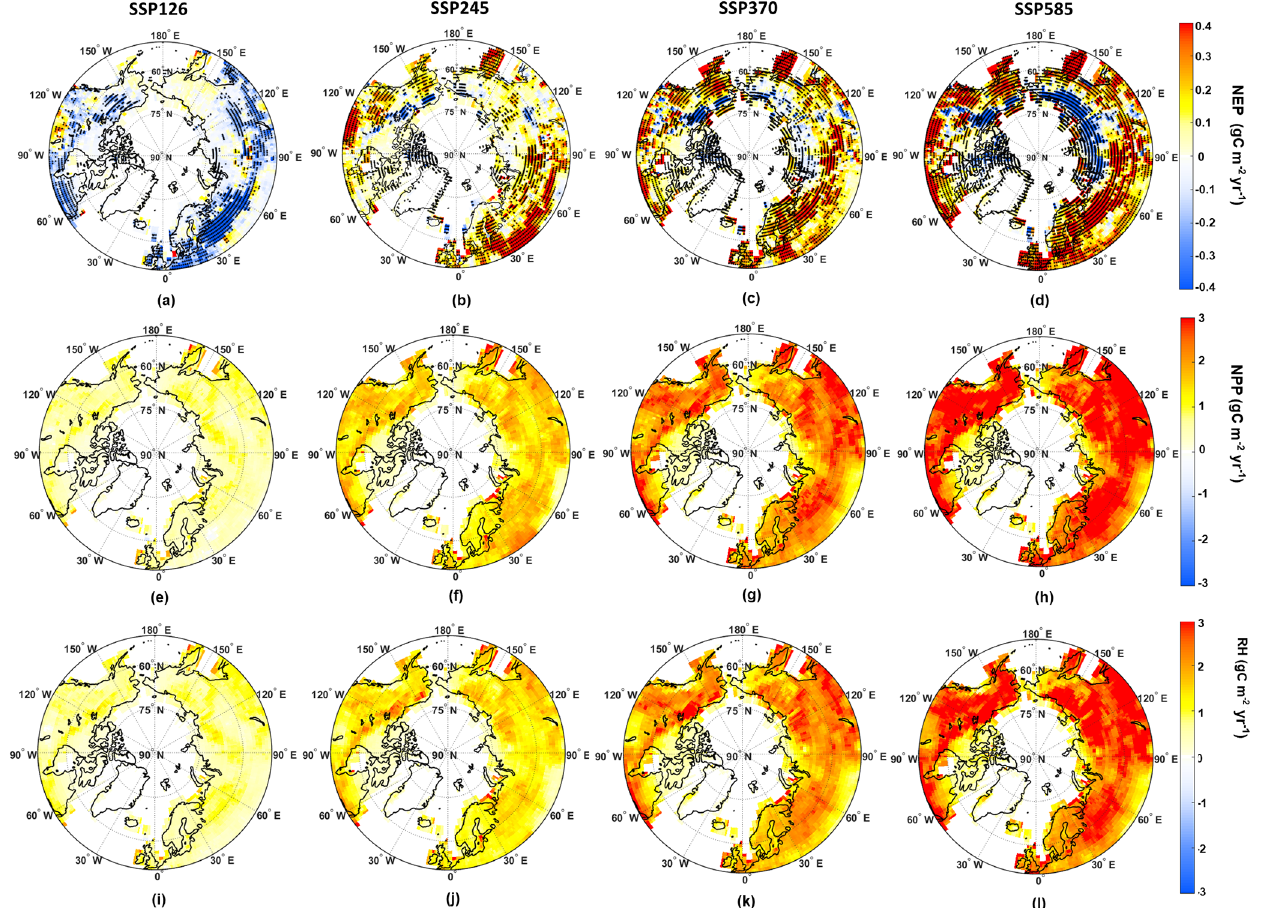
Figure 5. The spatial distributions of the trends of NHL carbon fluxes under different future scenarios. The rows of the panels are NEP, NPP, and Rh from top to bottom, and the columns of the panels are SSP126, SSP245, SSP370, and SSP585 from left to right. The unit is grams of carbon per square meter per year. The black dots on the NEP maps denote significance of the regression values ( p< 0 . 05) when fitting the carbon flux trends within each grid. Most of the model grids show significance of the regression for NPP and Rh and are not shown on the